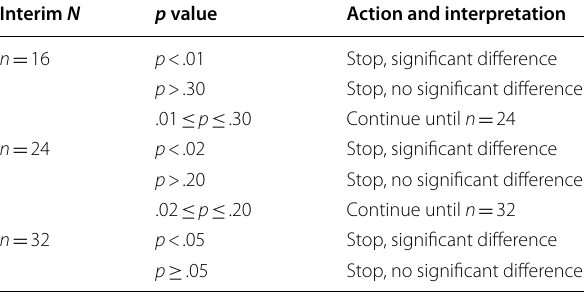
Table 1 The sequential procedure used to determine sample size Interim N p value Action and